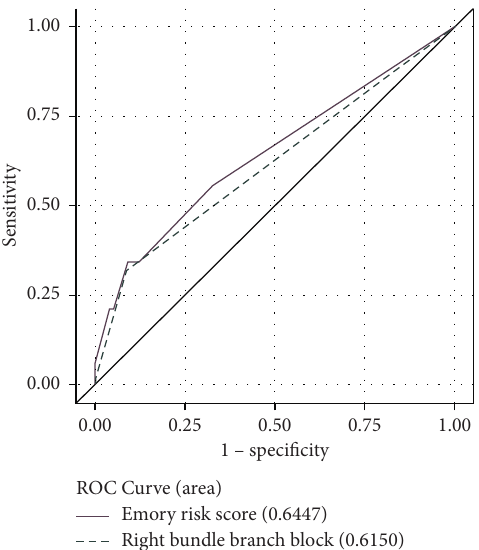
Figure 1: ROC curve for balloon-expandable valves.